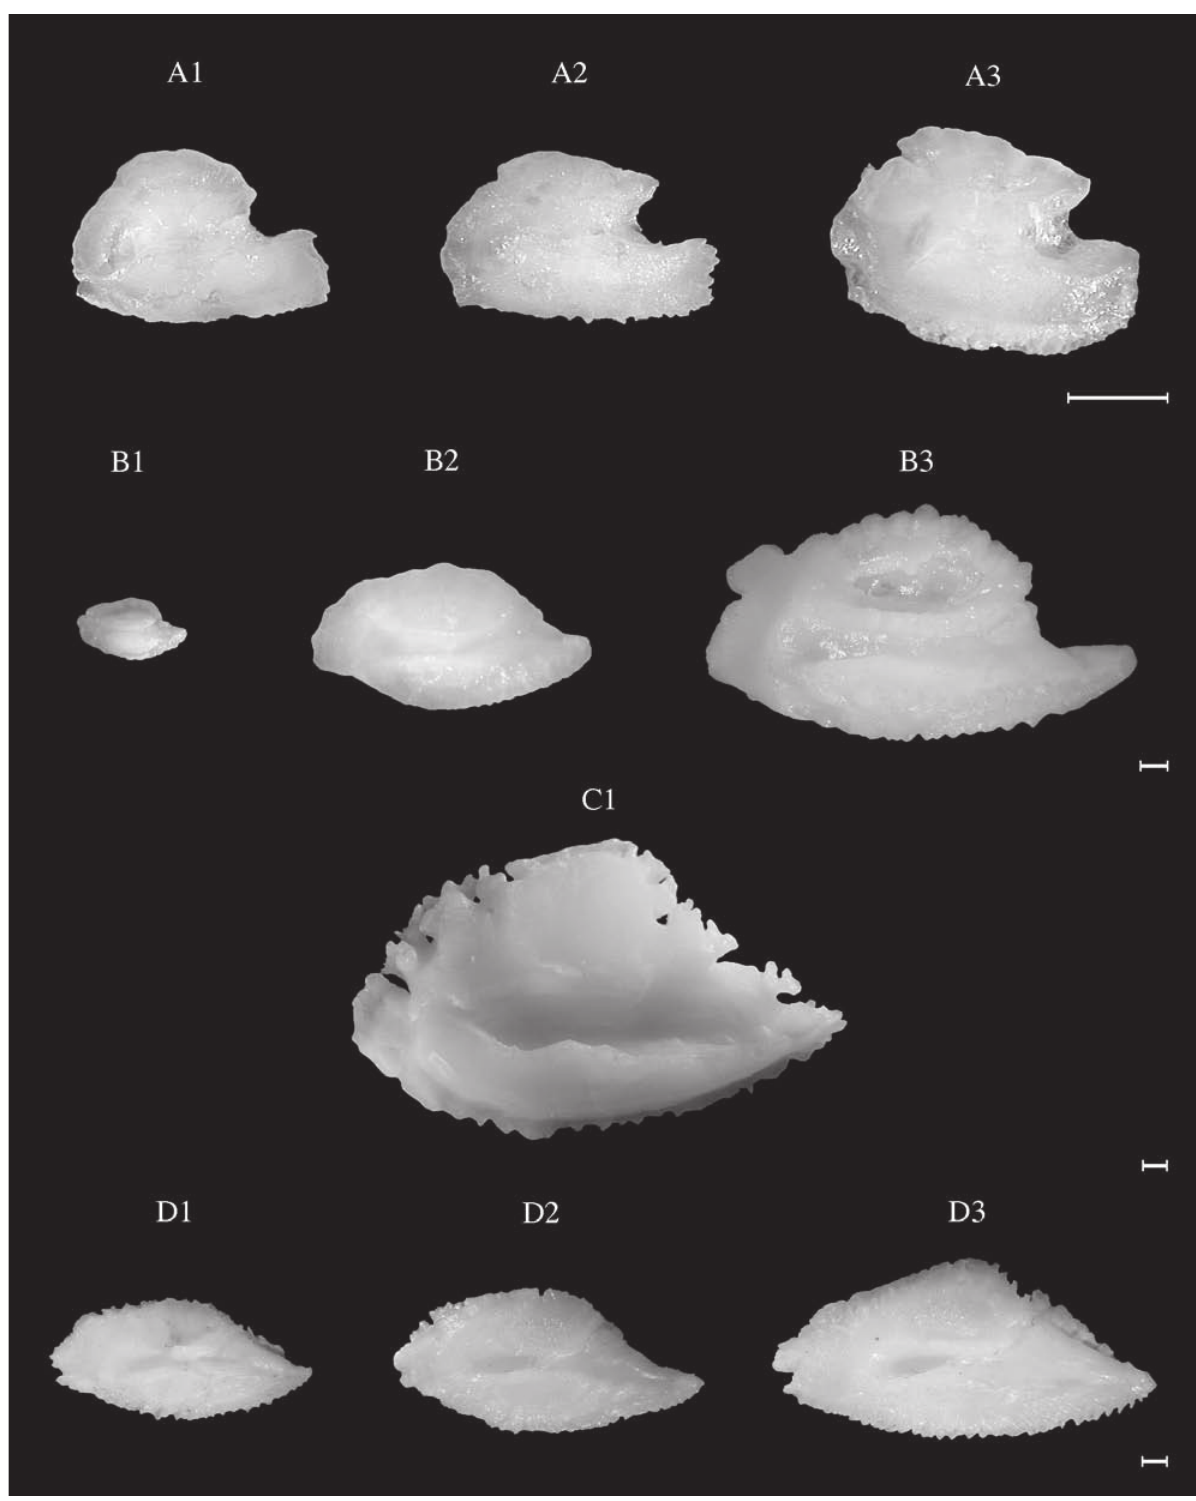
Fig. 41. – Dactylopterus volitans (WM). TL: A1, 24.5 cm; A2, 28.0 cm; A3, 36.5 cm. Helicolenus dactylopterus . TL: B1, 8.5 cm (WM); B2, 23.6 cm (NEA); B3, 43.0 cm (CEA). Neomerinthe folgori (CEA). TL: C1, 57.4 cm. Pontinus kuhlii (CEA). TL: D1, 22.0 cm; D2, 29.5 cm; D3, 37.5 cm. Scale bar = 1